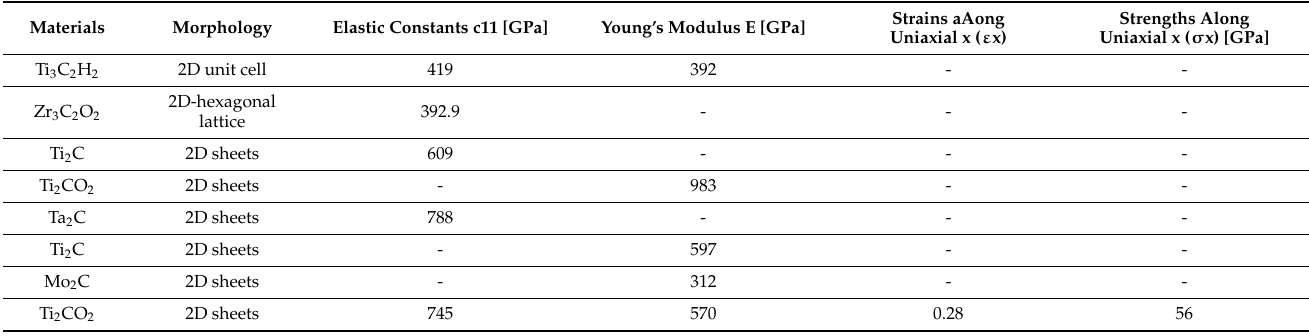
Table 2. MXenes with various compositions have varying mechanical characteristics